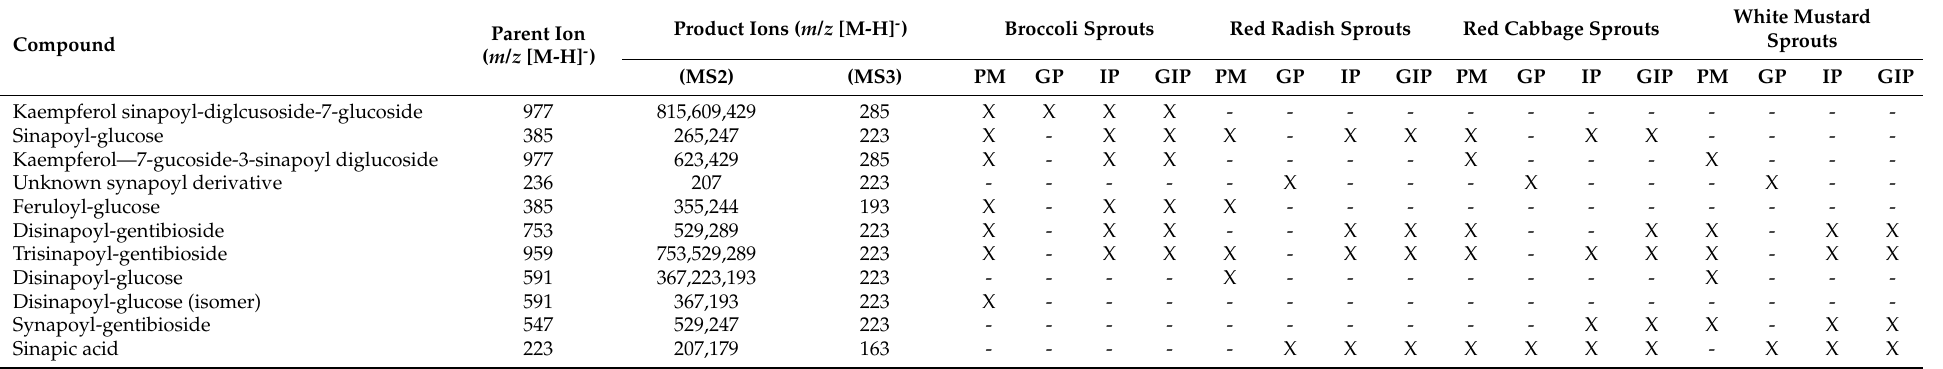
Table 2. Qualitative HPLC-DAD-ESI/MSn analysis of the individual hydroxycinnamic acids and flavonols present in raw material and digested broccoli ( Brassica olreacea var. italica L. cv. ‘Calabrese’), red radish ( Raphanus sativus var. Sativus L. cv. ‘Rambo’), white mustard ( Sinapis alba ), and red cabbage ( Brassica rapa, var. capitata ) extracts.